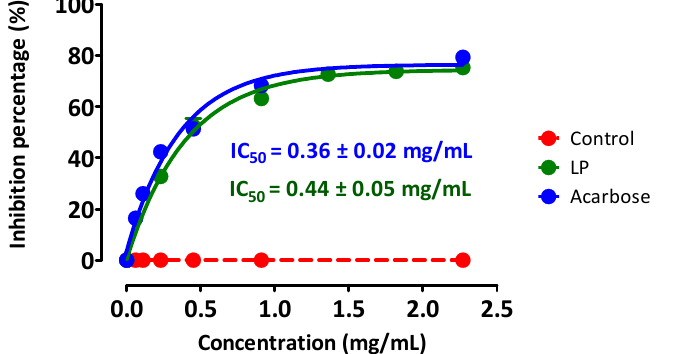
Figure 4. Inhibiting effect of the LP aqueous extract and acarbose on the pancreatic α -amylase enzyme activity. α -amylase was mixed and incubated with starch in the presence or absence of LP extract. Arcabose (medicine) was used as positive control.